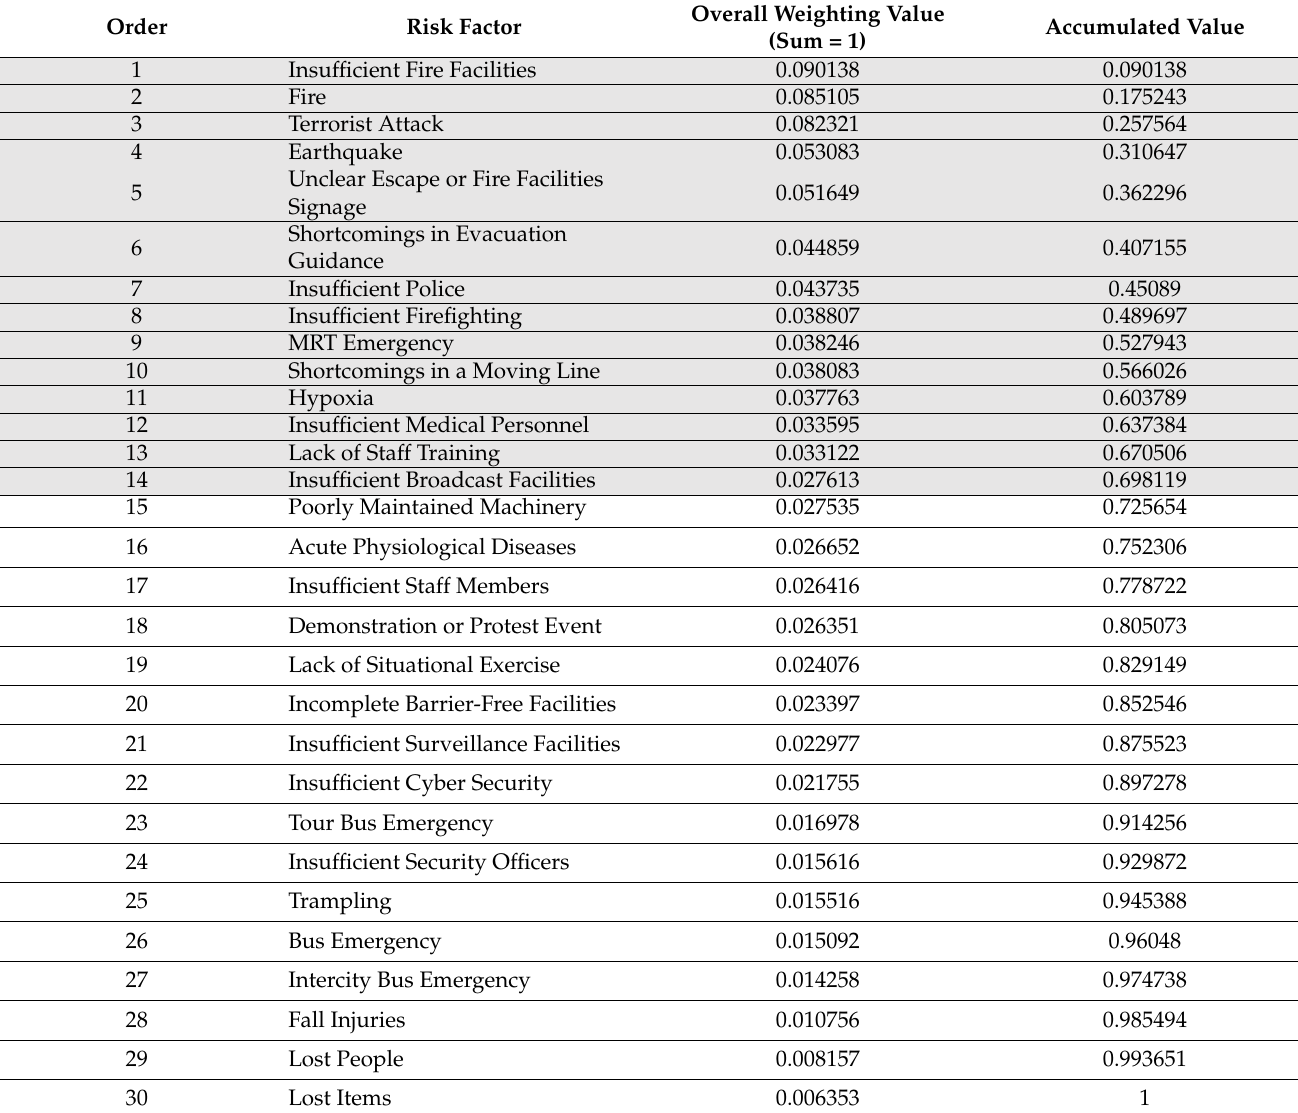
Table 9. Accumulated values for risk